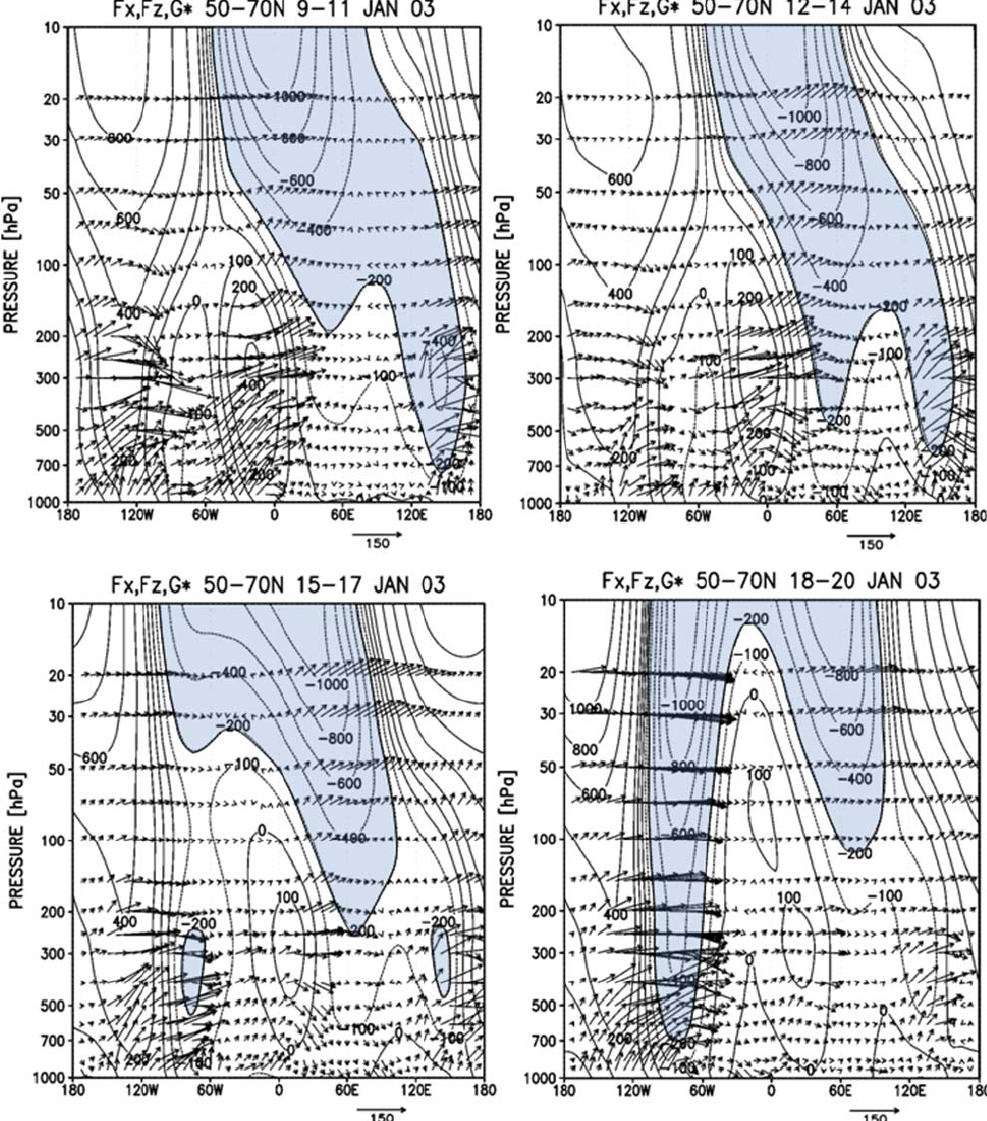
Fig. 13. Altitude-longitude cross-section of geopotential height perturbation (m), negative isolines are dotted; Plumb flux vector (m 2 s − 2 ) averaged over 50 ◦ –70 ◦ N based on 3-day means; 9–11 January 2003 (a) , 12–14 January (b) , 15–17 January (c) , and 18–20 January 2003 (d) . The vertical component of Plumb-flux is multiplied by a factor of 100.